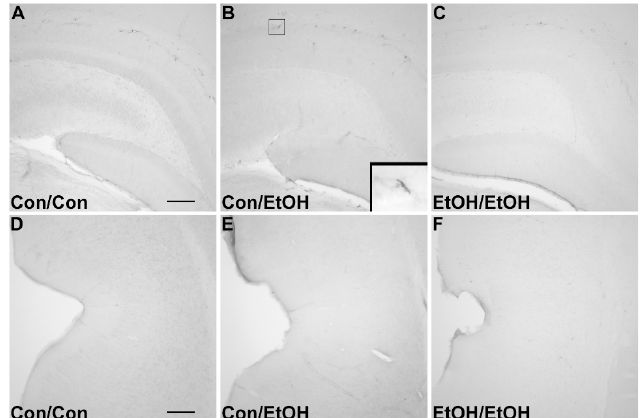
Figure 3. Lack of ED-1 Positive Cells. ED-1 was not visible in the parenchyma of the ( A – C ) hippocampus or ( D – F ) entorhinal cortex as seen in representative photomicrographs in ( A , D ) controls, ( B , E ) Con/EtOH ( C , F ) or EtOH/EtOH groups. ED-1 positive cells could be seen along the hippocampal fissure and blood vessels as shown in the inset of B. Scale bars = 200 µm.